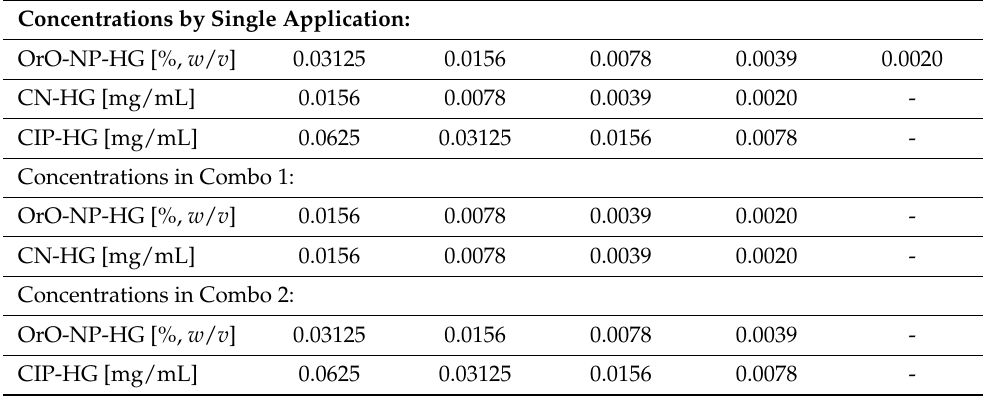
Table 5. Schema of the tested combinations on MRSA.